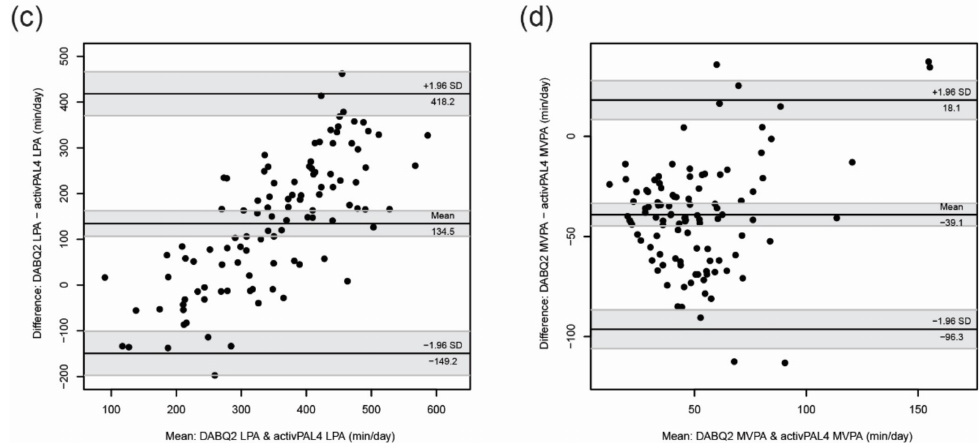
Figure 1. Bland–Altman plots comparing DABQ2 and activPAL4 estimates of ( a ) sleep duration, ( b ) time spent in SB, ( c ) time spent in LPA, and ( d ) time spent in MVPA. Lines show the mean difference and limits of agreement while shaded areas show their 95% confidence intervals. DABQ2, Daily Activity Behaviours Questionnaire completed on the second occasion; activPAL4, activPAL4 accelerometer/inclinometer; Sleep, sleep duration; SB, time spent in sedentary behaviour; LPA, time spent in light physical activity; MVPA, time spent in moderate-to-vigorous physical